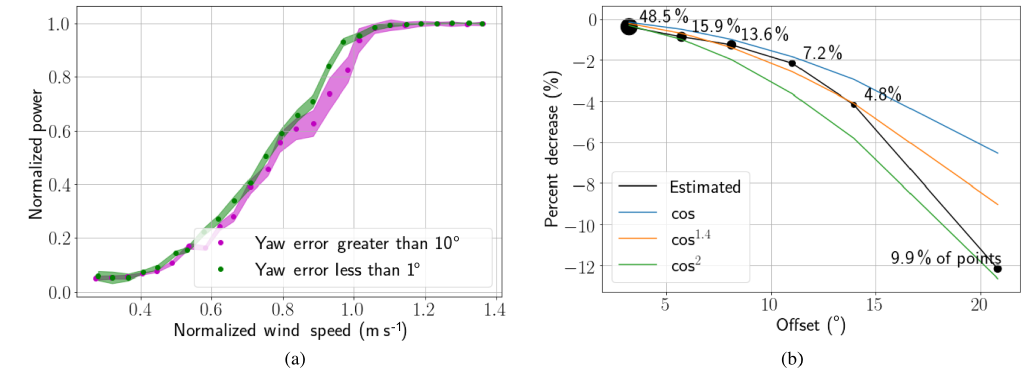
Figure 11. (a) The power curve of a single turbine was computed using 0.5ms − 1 bins over 500h of data. The power curve is plotted for small wind direction errors of less than 10 ◦ (green) and large wind direction errors of more than 10 ◦ (magenta). (b) The power loss is computed for different yaw offset angles. The trend is consistent with cosine power laws seen in literature.